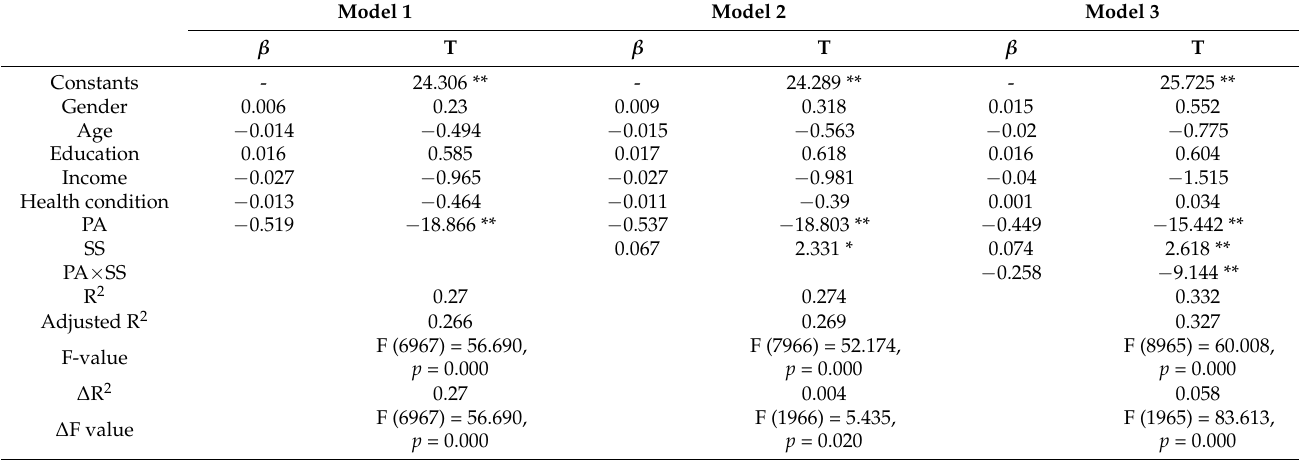
Table 7. Moderating effect